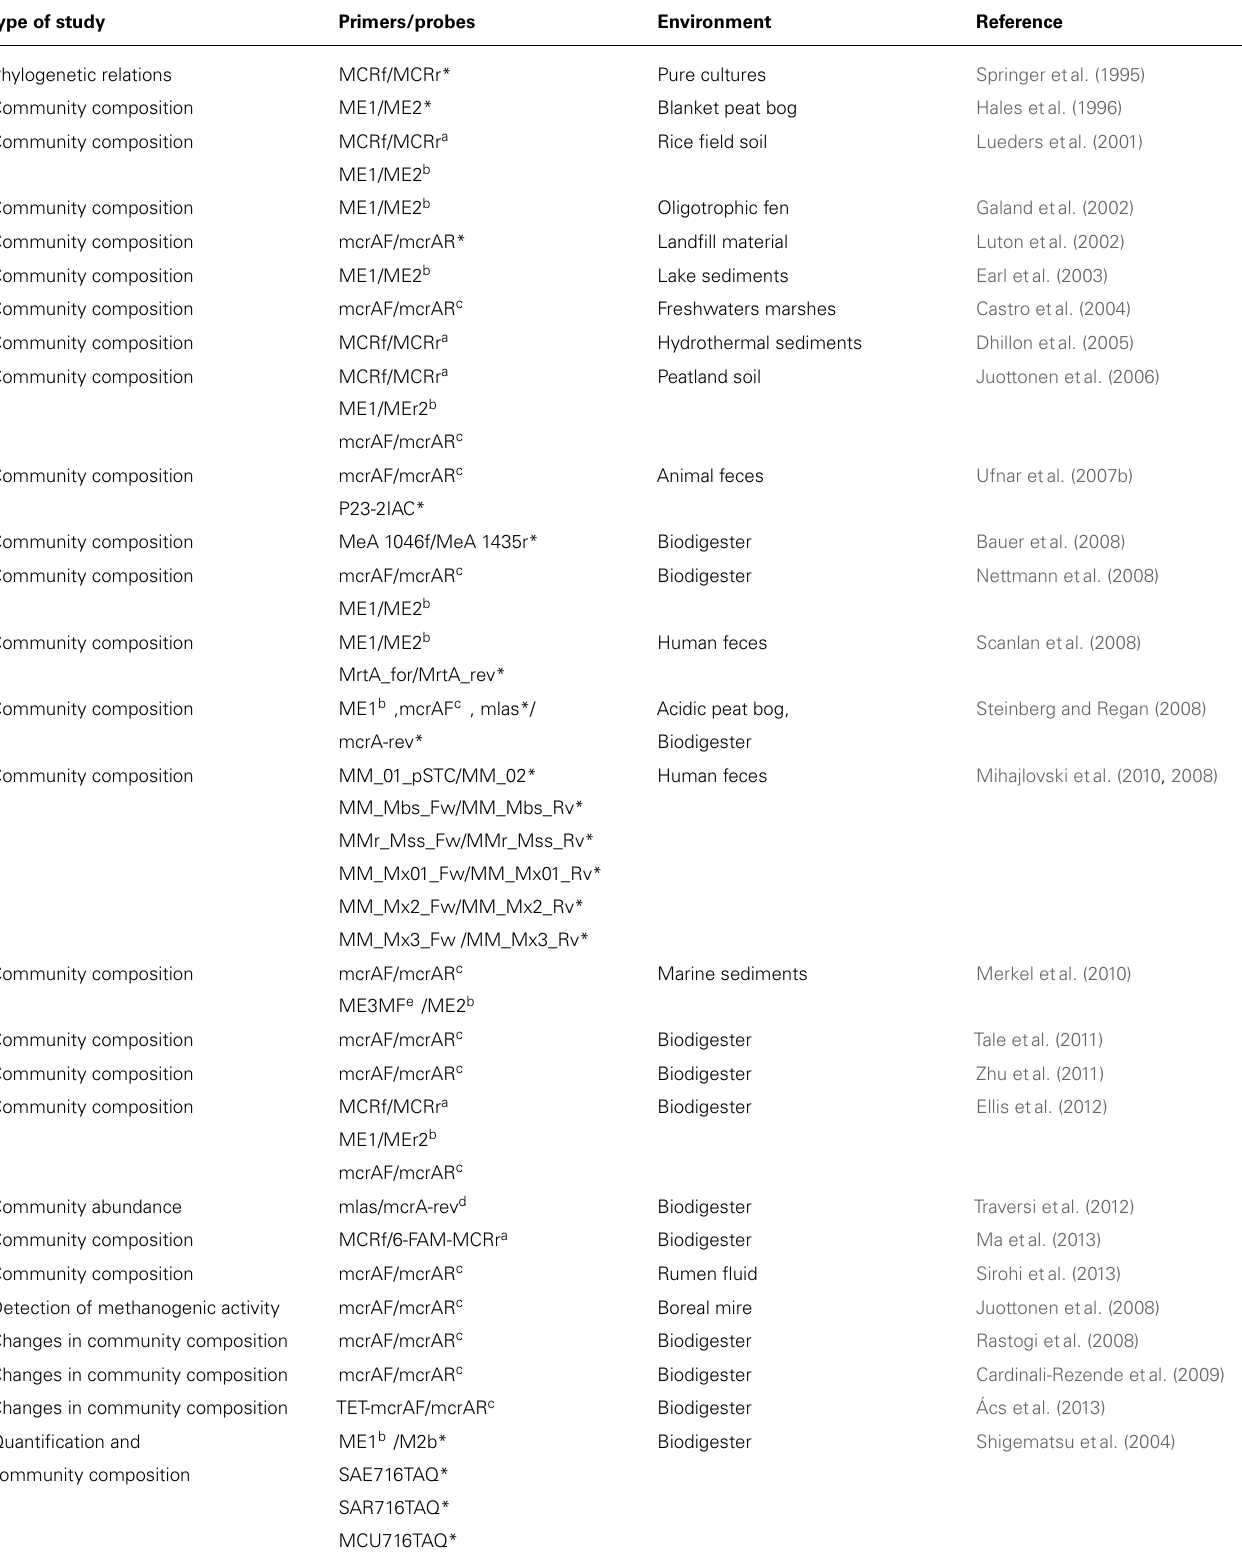
Table 1 |Application of mcr A gene in studies related to biodigester and other natural anaerobic